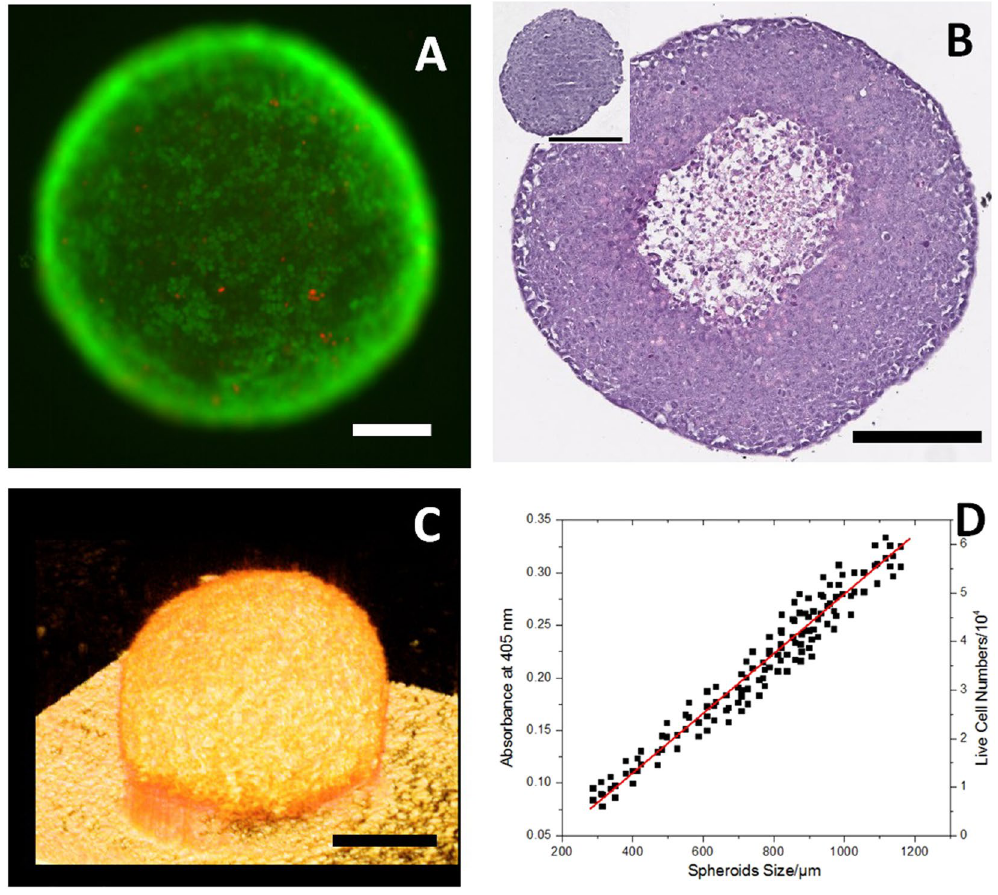
Figure 5. Basic tumor spheroid characteristics. ( A ) Representative dead/live staining on a HCT116 spheroid. ( B ) Representative microscopic images of H&E stained 5 µ m paraffin embedded sections of HCT116 spheroids with (the bigger one) and without (the smaller one) central secondary necrosis. ( C ) 3D OCT images of a HCT116 spheroid with 558 µ m diameter showing that spherical shape is maintained for the large spheroid. ( D ) The linear relationship between spheroid size and its live cell numbers. ( D ) Was plotted with about 130 spheroids with size ranging from 300 µ m to 1200 µ m. Scale bars = 200 μ